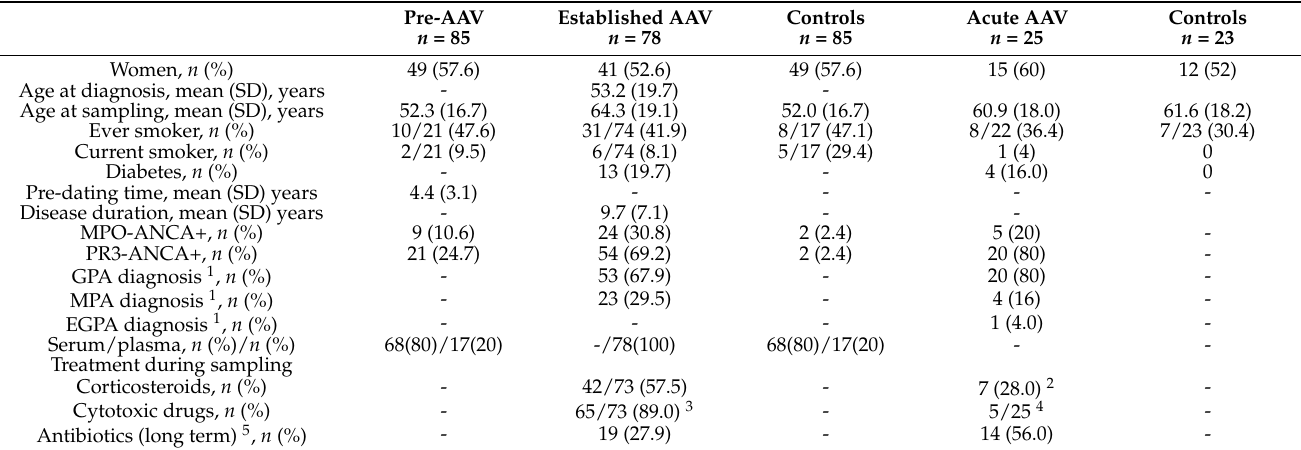
Table 1. Characteristics of study